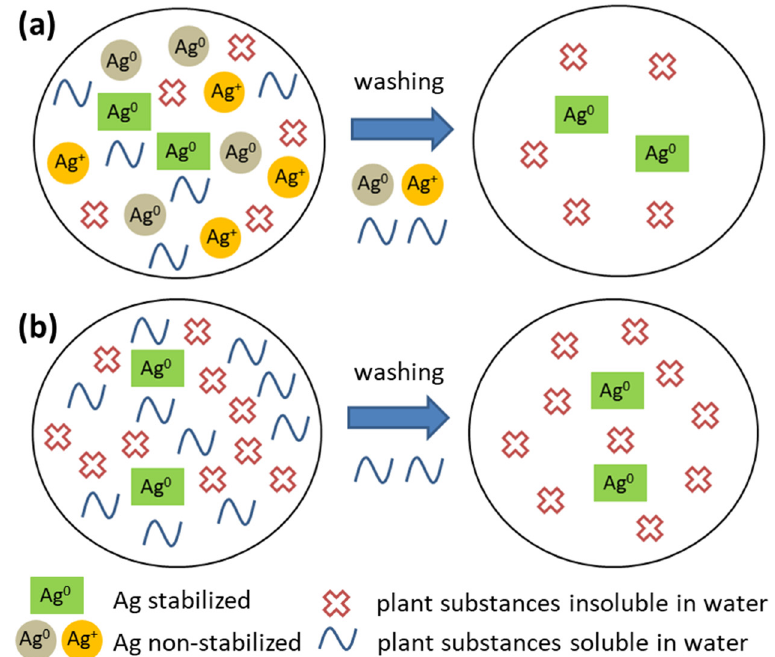
Figure 3. Scheme depicting the washing process for the samples of different AgNO 3 :plant mass ratios: